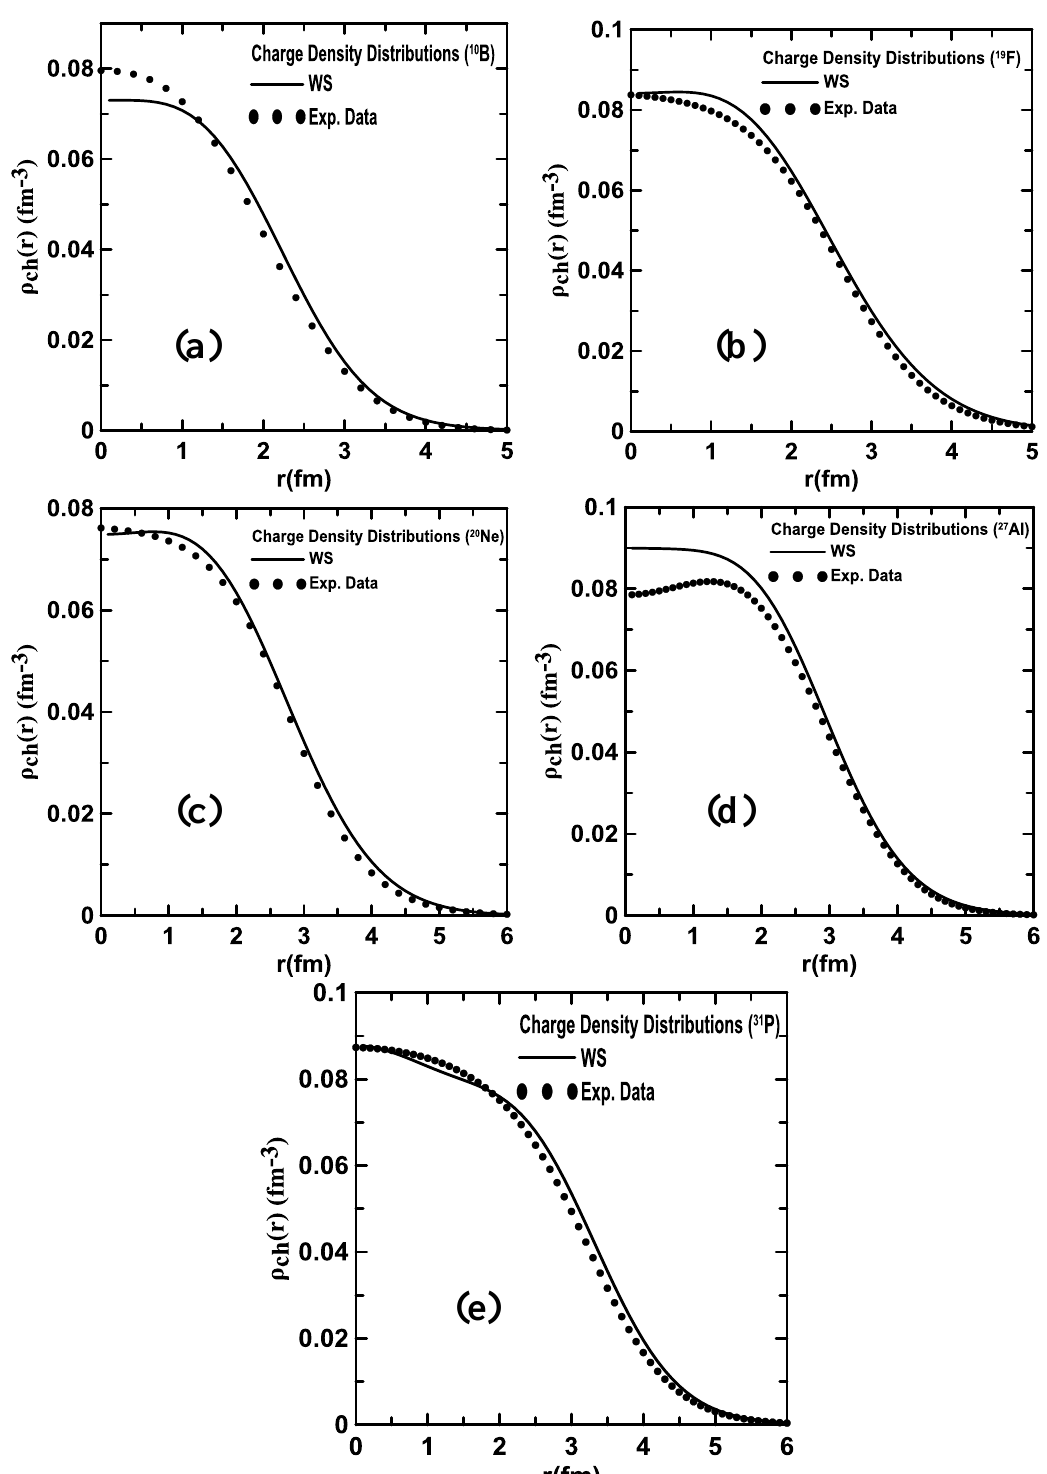
Fig. 1: Calculated charge density distributions for 10 B (a), 19 F (b), 20 Ne (c), 27 Al (d) and 31 P (e) the dotted symbols represent experimental data